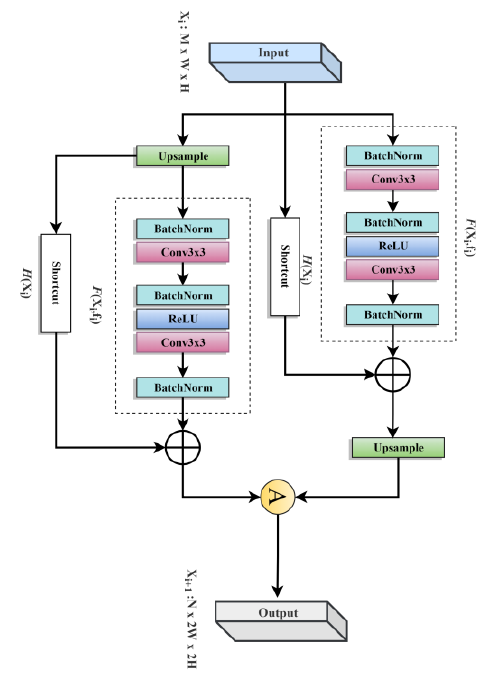
Figure 2. The proposed RUM+ structure used in the decoder part of the segmentation